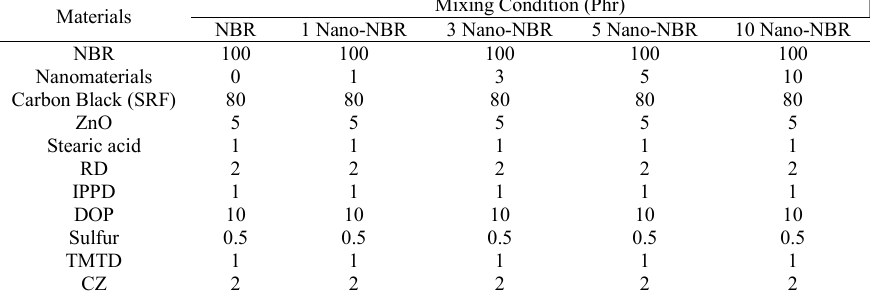
Table 3. Constituent components of fabricated nanofiller/NBR